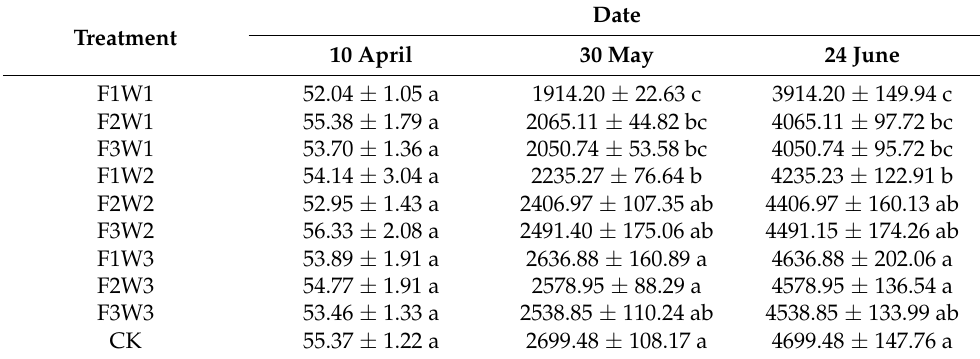
Table 4. Leaf area (mm 2 ) of sweet pear under different